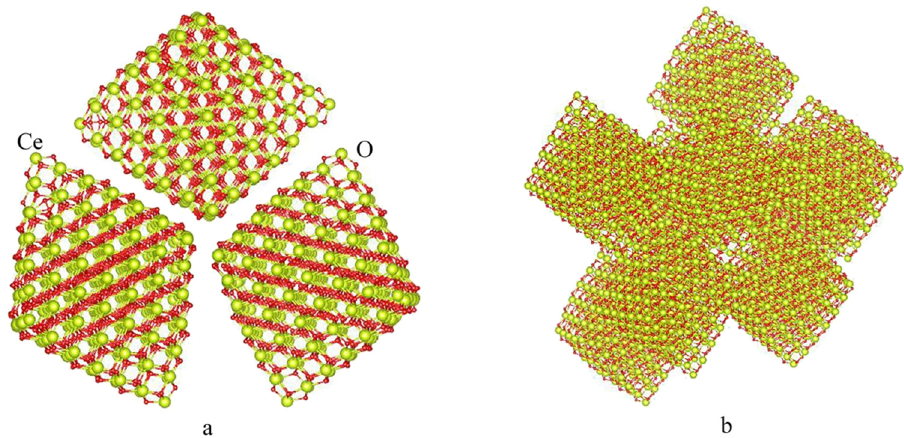
Figure 2: Structure of agglomerated nanoparticles with a size of ( a ) 4.7 nm and ( b ) 7.3 nm. The cerium and oxygen atoms are depicted by yellow and red balls,